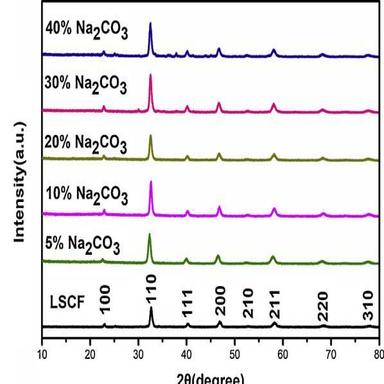
XRD patterns of the pure LSCF and LSCF/Na2CO3 composite with different weight ratios.